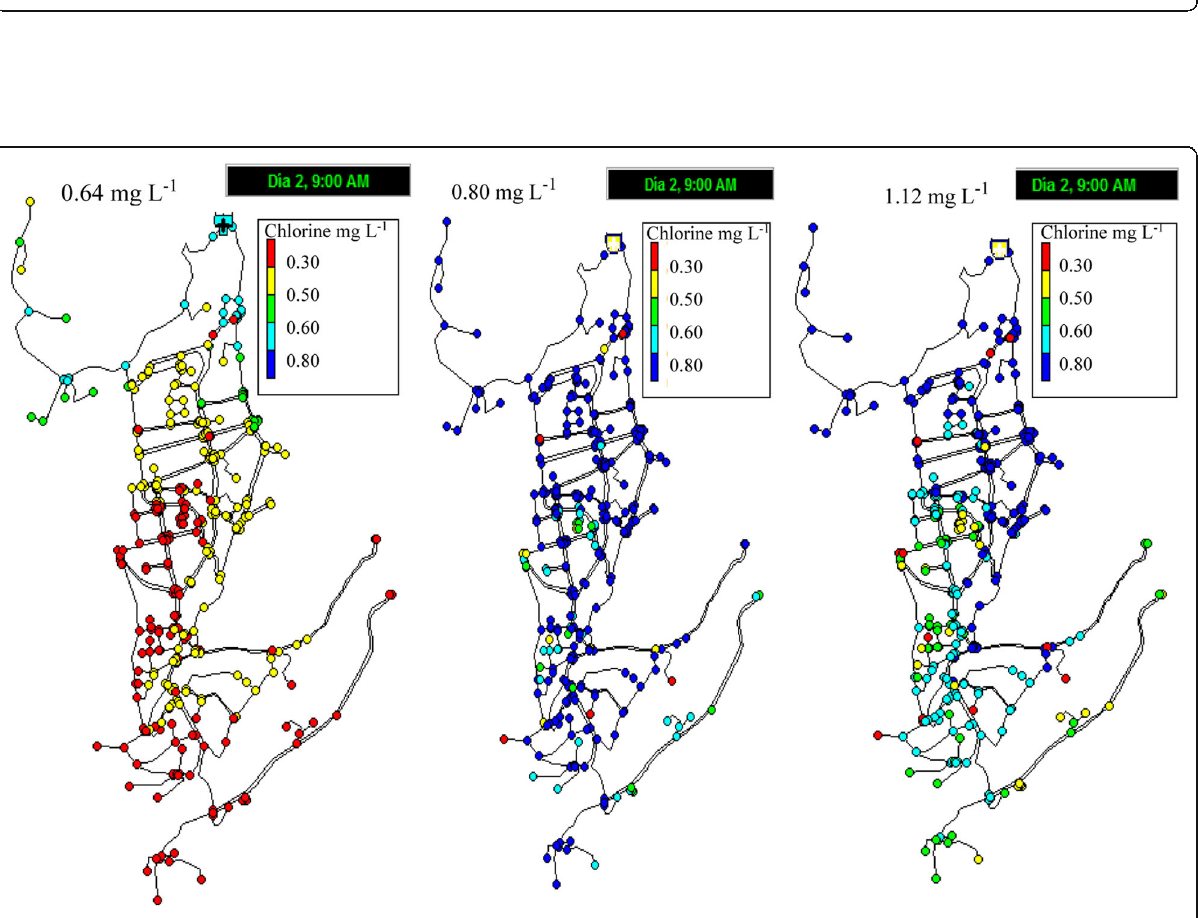
Fig. 7 Sensitivity of the chlorine concentration simulated by the model through the changes in the kb and kw parameters in the distribution network. dC C − 1 is the relative change in the simulated chlorine concentration and dP P − 1 is the relative change in the values of the model parameters